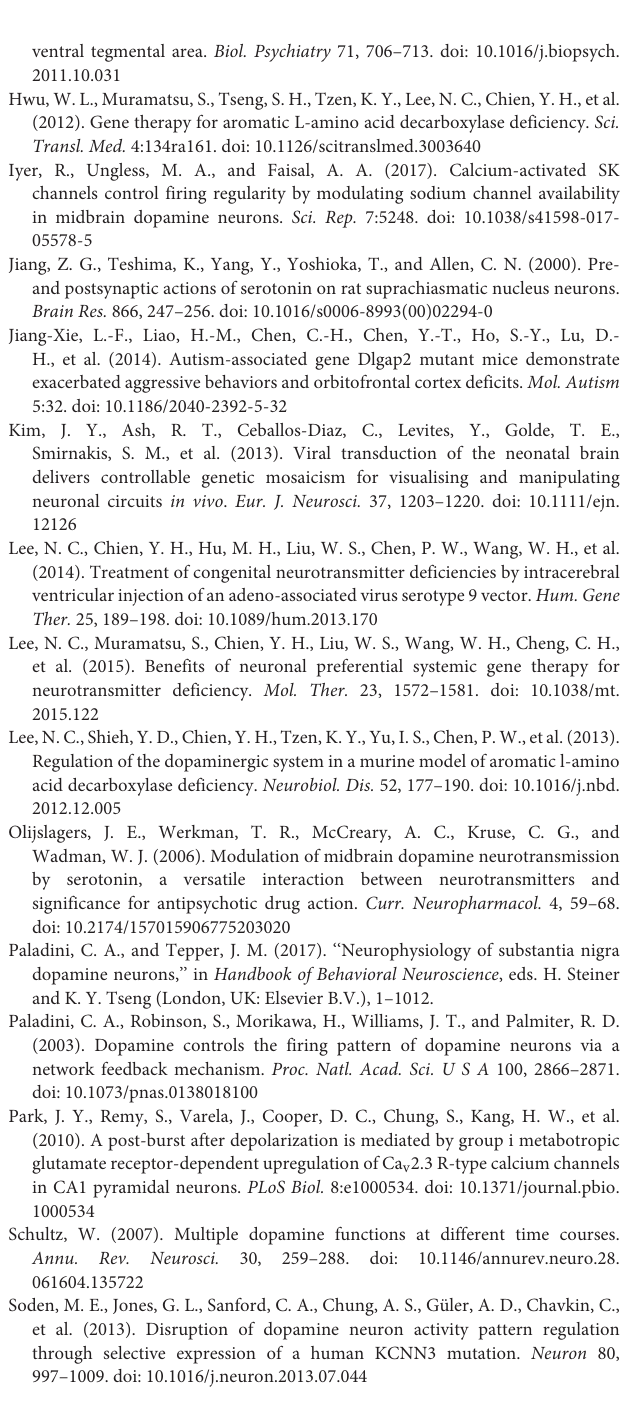
more irregular pattern. Interestingly, the Ddc KI DA neurons showed similar “bursting” firing pattern as observed in WT DA neurons. Scale bar: 20 mV and 5 s. (B) Comparison of the coefficient of variation of the interspike interval (CV-ISI). The Ddc KI DA neurons displayed a significantly higher CV-ISI than WT DA neurons. However, no differences were detected in the CV-ISI after NMDA-induced bursting. Data were collected from three neurons in the WT group and two neurons in the KI group. ∗ p < 0.05; ns, not significant. TABLE S1 | Gene expression in SNc of Ddc KI mice ( n =